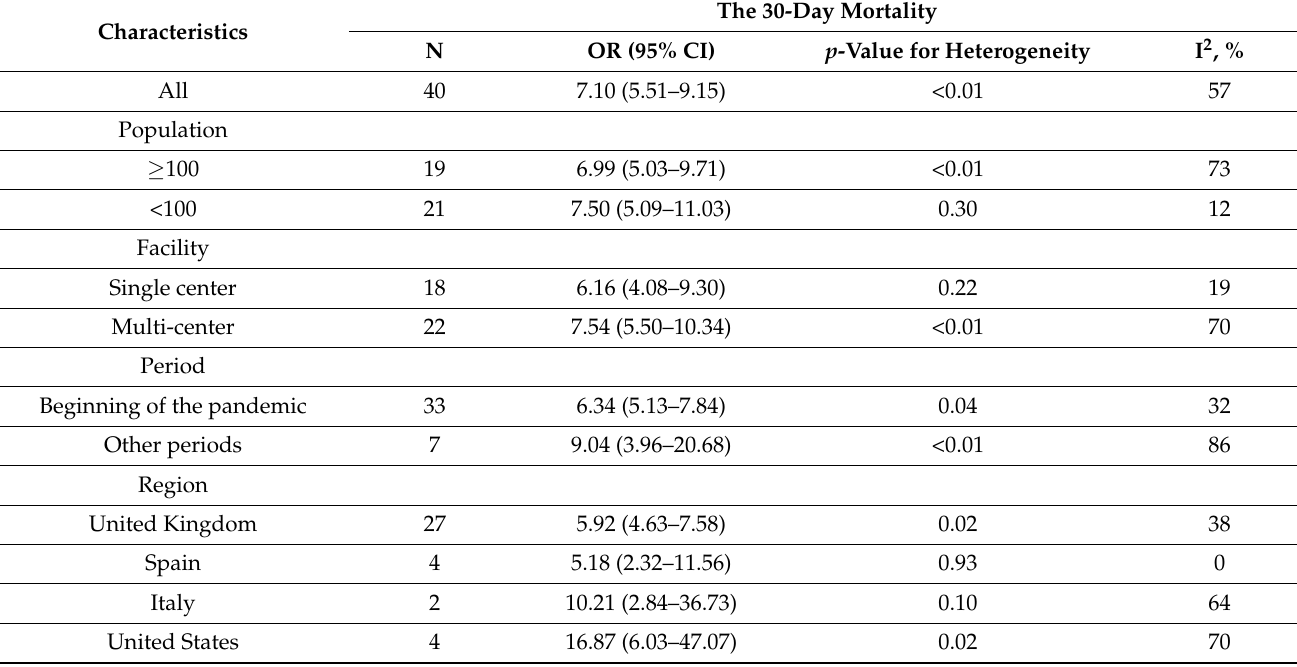
Table 2. Subgroup analysis for the 30-day mortality of hip fractures in patients with and without COVID-19.